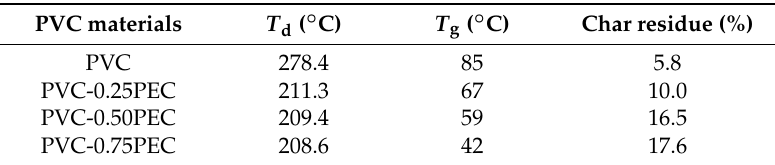
Table 2. TGA and DSC data of PVC materials.